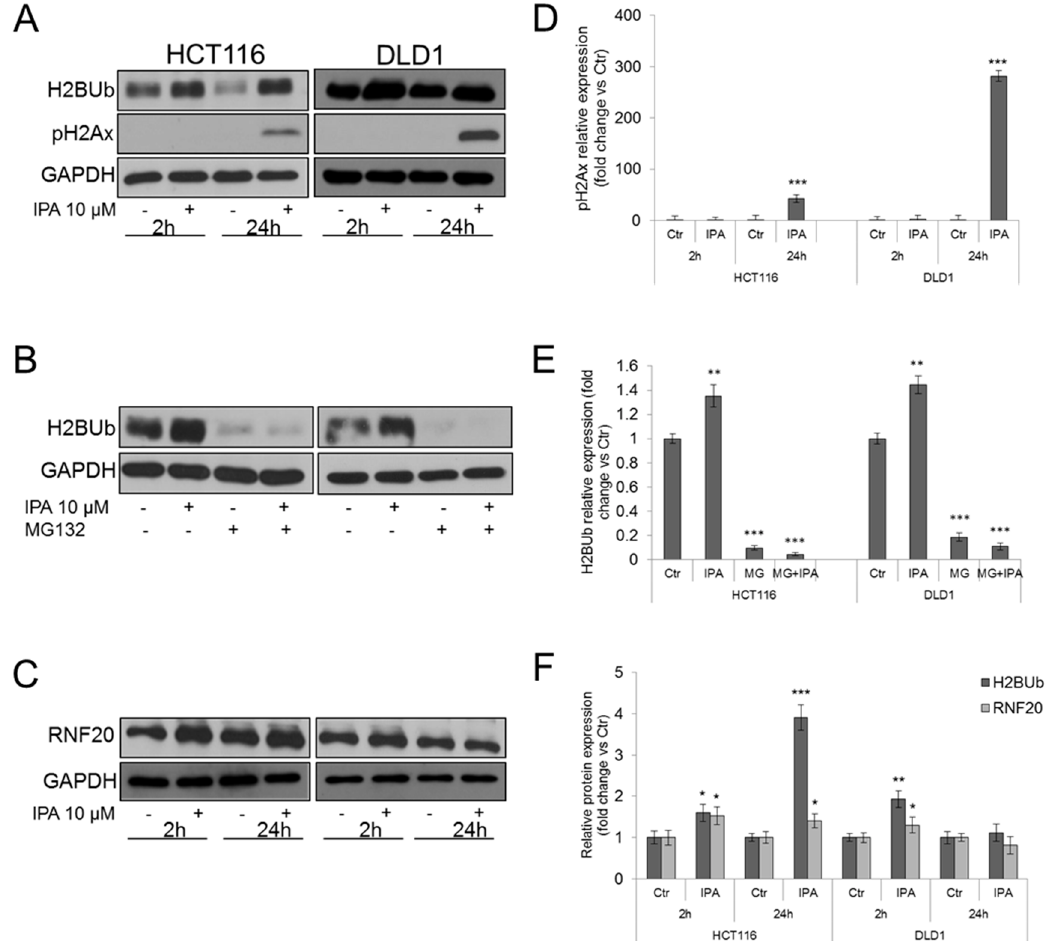
Figure 5. IPA regulates RNF20-mediated histone H2B ubiquitination. Western blot and densitometry analysis of ( A , D ) phosphorylated histone H2Ax and ( A , F ) Ubiquitinated histone H2B amount, in IPA-treated HCT116 and DLD1 cells; ( B , E ) histone H2B monoubiquitination after 2 h of treatment of HCT116 and DLD1 cells with IPA 10 µM alone or after 1 h of pre-treatment with MG132; ( C , F ) RNF20 in IPA-treated HCT116 and DLD1 cells. GAPDH was used as loading control. Data are expressed as mean ± SD of five independent experiments. * p < 0.05, ** p < 0.01, *** p < 0.005 vs. control.